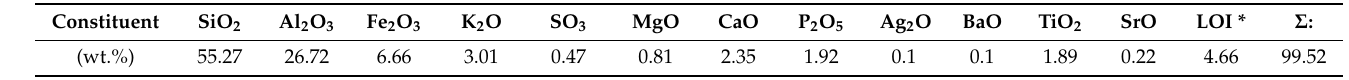
Table 3. Chemical composition of the FA.